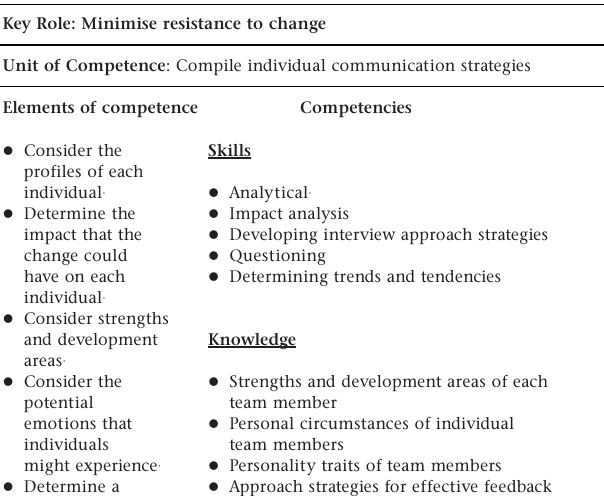
C OMPETENCIES TO COMPILE INDIVIDUAL COMMUNICATION